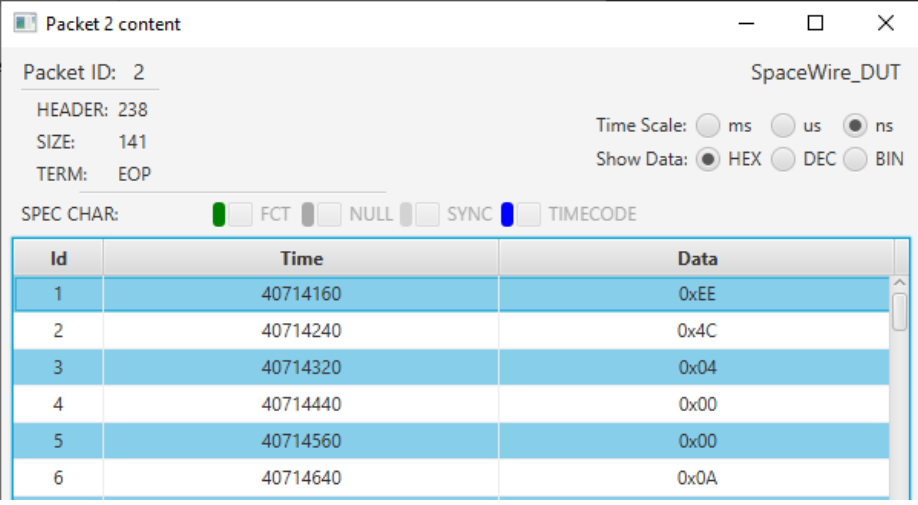
Figure 5. SpaceART Sniffer Graphical User Interface (GUI) visualization of the packet exchanged between a SpaceART EGSE and a SpaceWire Device Under Test (DUT).